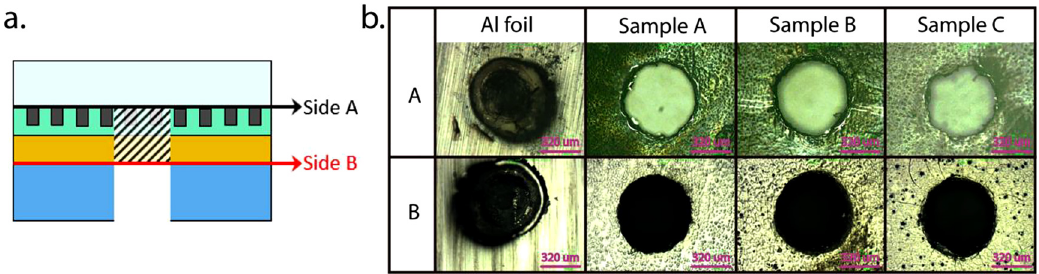
Figure 7: Surface morphology of the flyers after illuminated by pulse laser. (a)TheschematicdiagramoftheflyersurfacedenotedbySideAandB;(b)themicrographsofthetopandbottomsurfaceofthe fl yersfromthe Al foil sample, Sample A, B, and C.